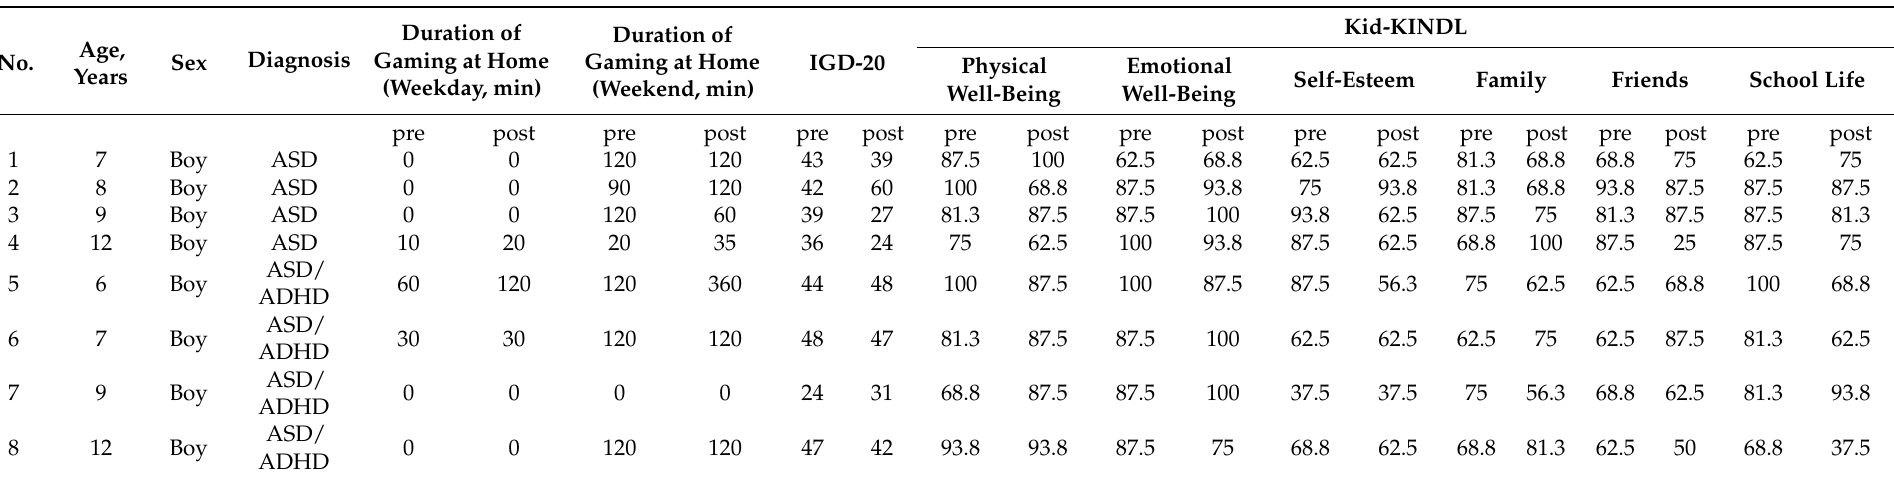
Table 1. Change in the data that were derived from the evaluation instruments after the Esports